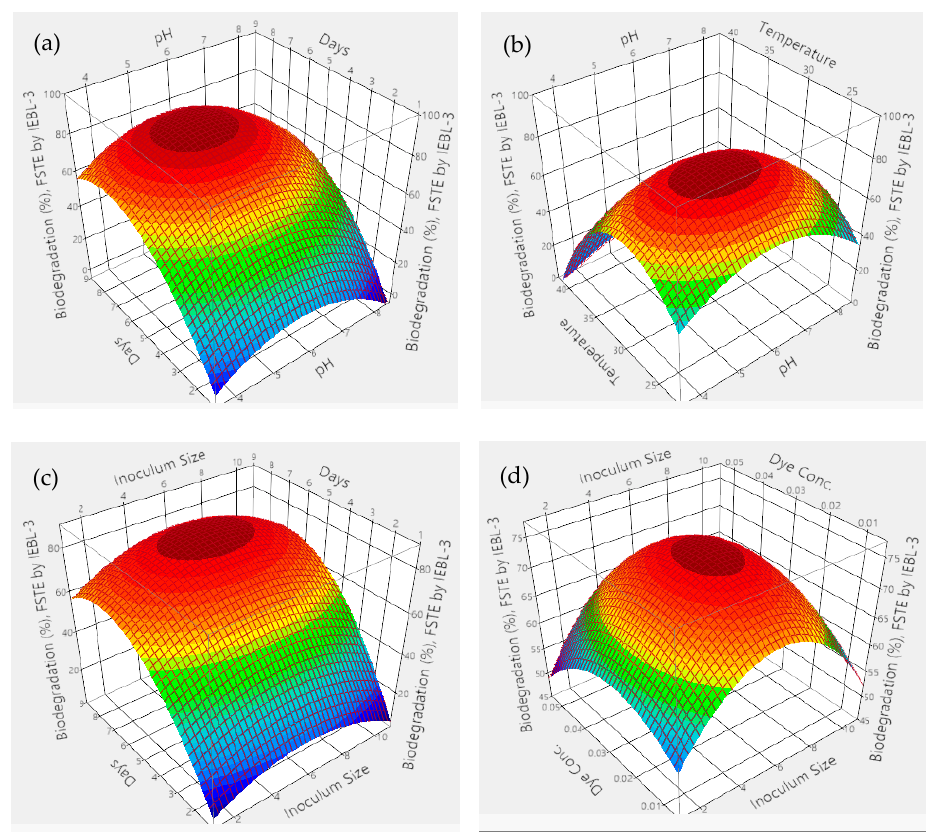
Figure 2. The 3D response surface graphs of the interaction between parameters during the bio ‐ degradation of FST industrial effluent by P. betulinus IEBL ‐ 3; there is positive interaction be ‐ tween ( a )—pH and time ( b )—pH and temp. ( c )—size of inoculum and time ( d )—size of inoculum and dye conc. ( e )—time and dye conc. ( f )—statistical analysis ( ⃰ indicate significance of value). During the current study, there was 67.10 ± 1.2% bio ‐ degradation of ST industrial effluent obtained. The most favorable conditions were pH 5.4, time of 08 days, size of inoculum 6.06 mL, temperature 26.90 °C and dye concentration 0.04%. The analysis of 3D graphs indicated that the maximum biodegradation achieved was the result of the posi